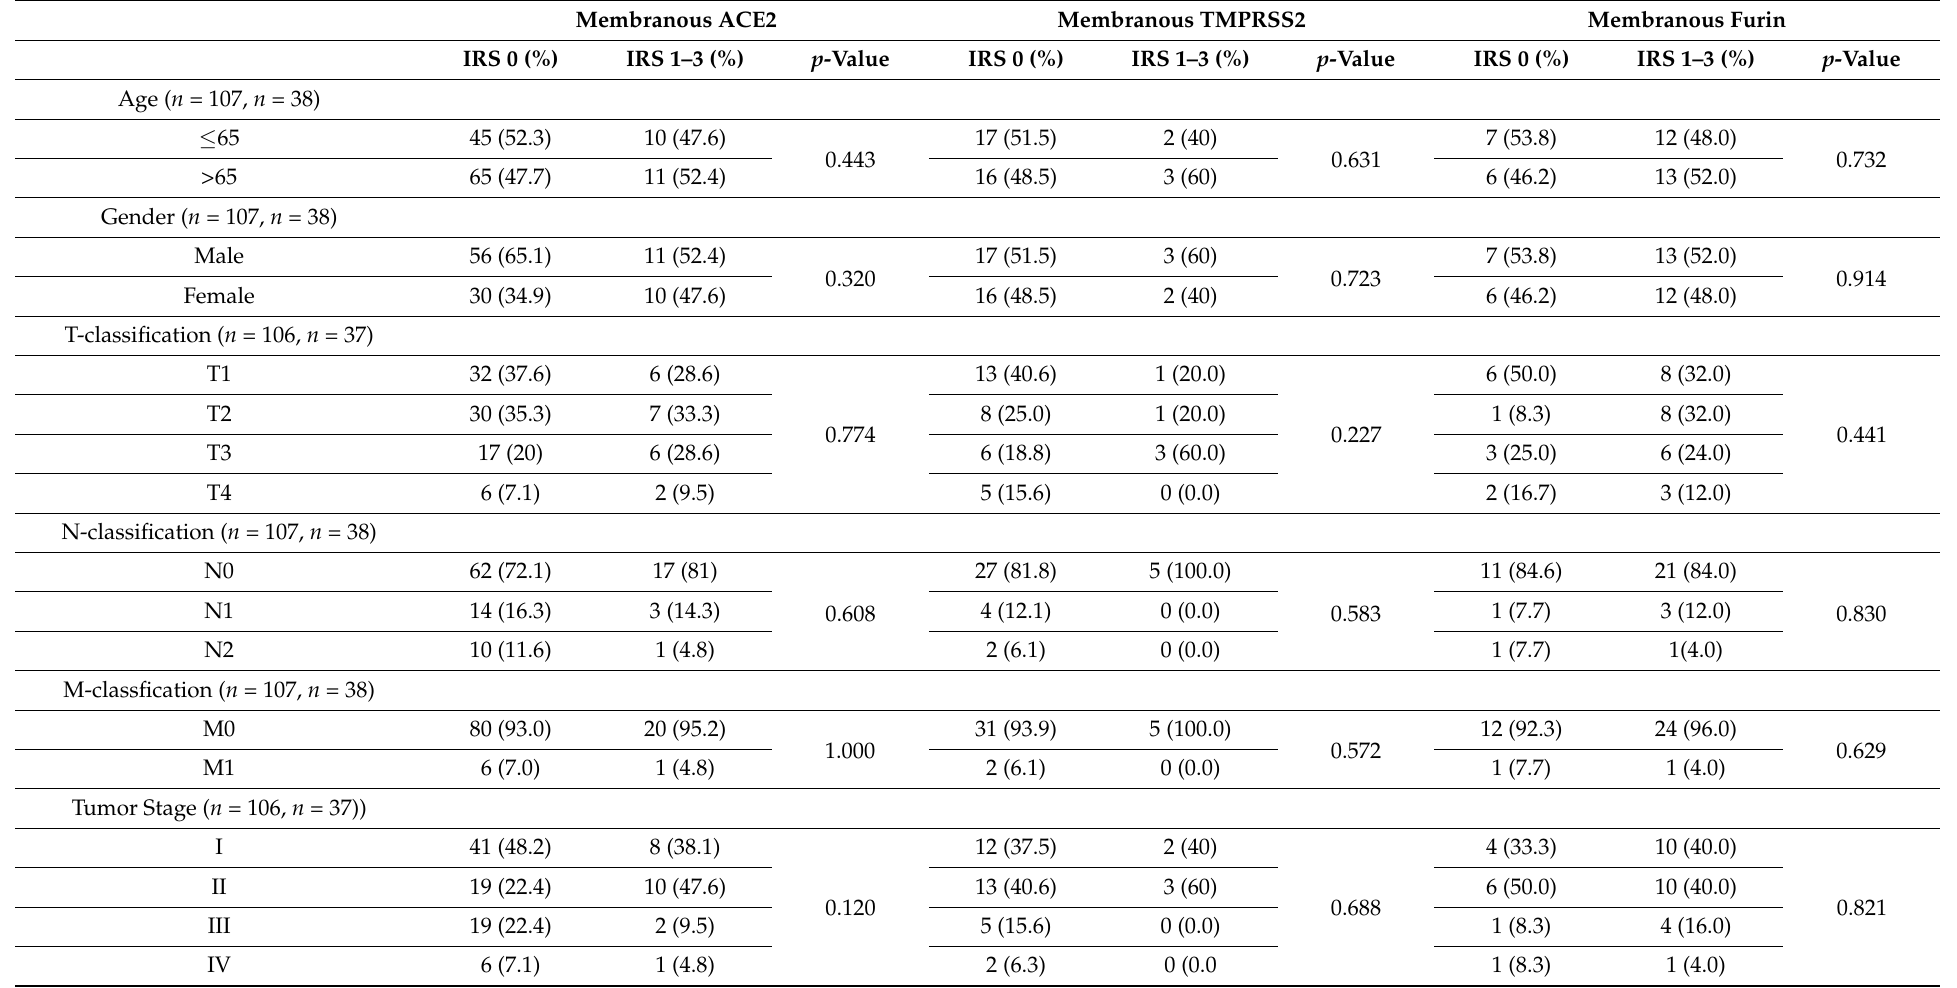
Table 2. Patient clinicopathological data in relation to ACE2 protein